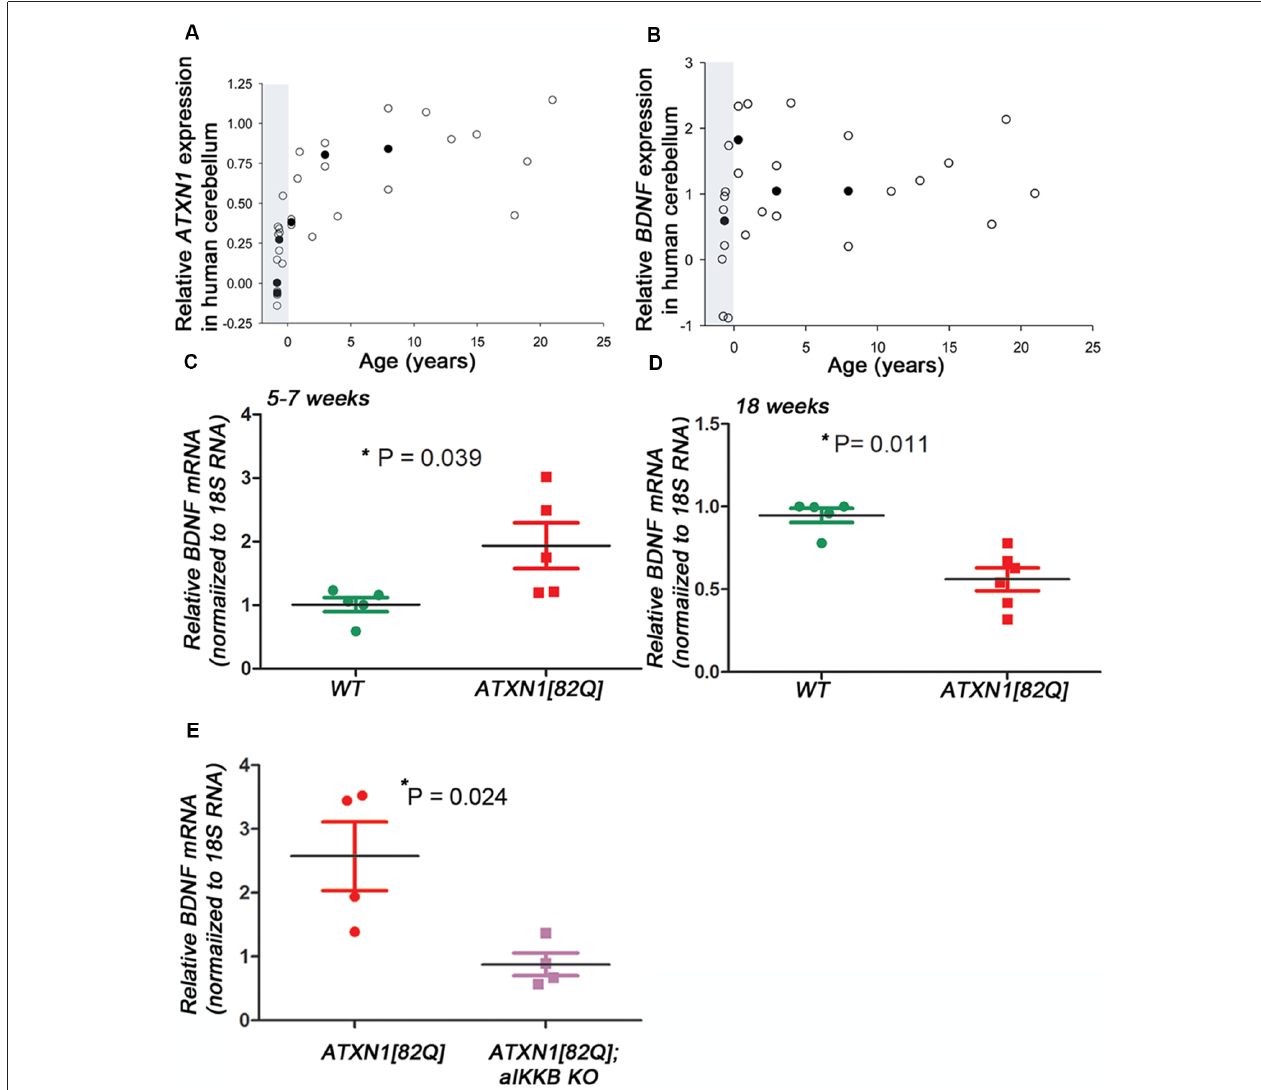
FIGURE 1 | Brain derived neurotrophic factor (BDNF) expression in transgenic spinocerebellar ataxia type 1 (SCA1) mice. (A–B) Relative Ataxin-1 (ATXN1) (A) and BDNF (B) expression in the human cerebellar cortex [polyglutamine (polyQ) sequence/SCA1 status unknown] obtained from the transcriptome data at Allen Brain Institute . Raw reads per kilobase million (RPKM) values were normalized to the highest and lowest values and data was averaged when multiple patient samples fell within the same postnatal year or same post conception week. Open circles represent single patient samples and closed circles represent average expression (used when possible). Shaded areas mark pre-natal period. (C–E) Reverse transcription and quantitative polymerase chain reaction (RT-qPCR) using cerebellar extracts from (C) early stage (5–7 weeks) and (D) late stage (18–24 weeks old) ATXN1[82Q] mice. Results are normalized using 18S RNA and age-matched wild-type (WT) littermates. (E) RT-qPCR using cerebellar extracts from ATXN1[82Q] mice and mice in which astroglial nuclear factor κ -light-chain-enhancer of activated B cells (NF- κ B) is inhibited early in disease [ ATXN1[82Q] ; aIKK β KO]. Results are normalized using 18S RNA and age-matched WT littermates. For (C–E) error bars = SEM. Student’s t -test P values. Each dot represents a biological